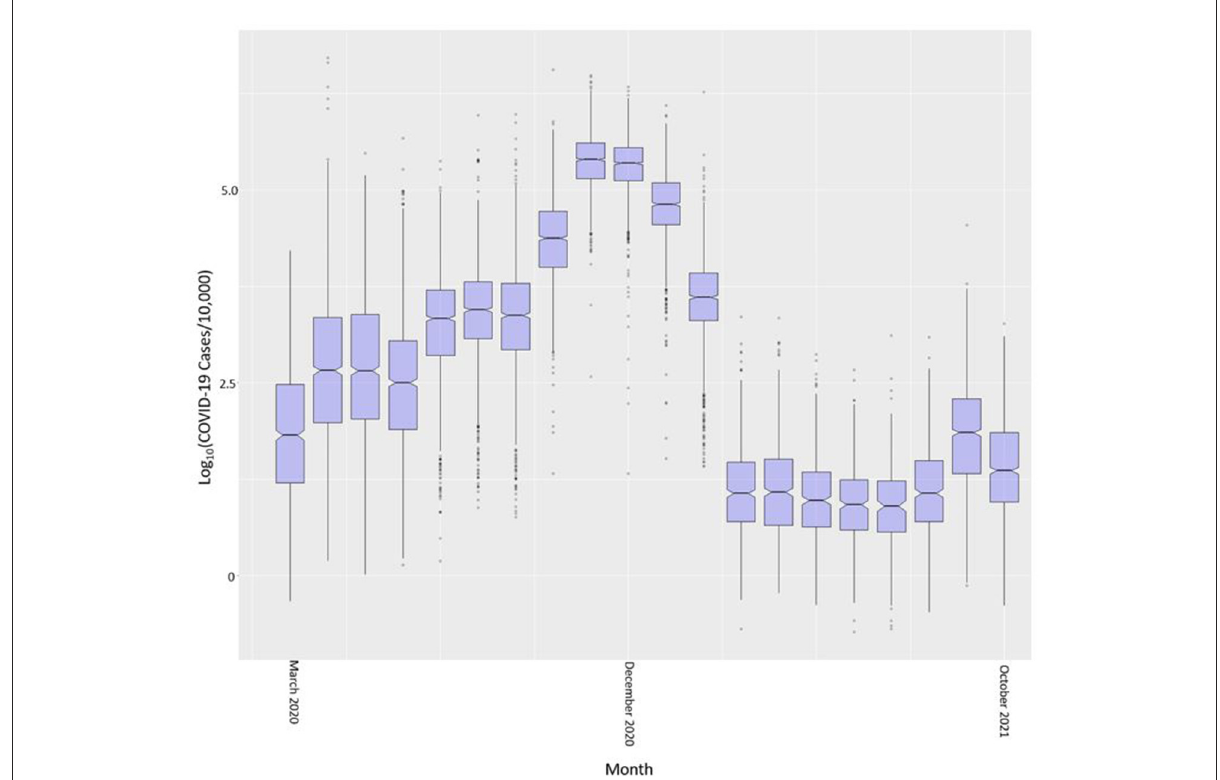
FIGURE4 COVID-19 case rate per 10,000 (in common logarithm) by month across all Indiana census